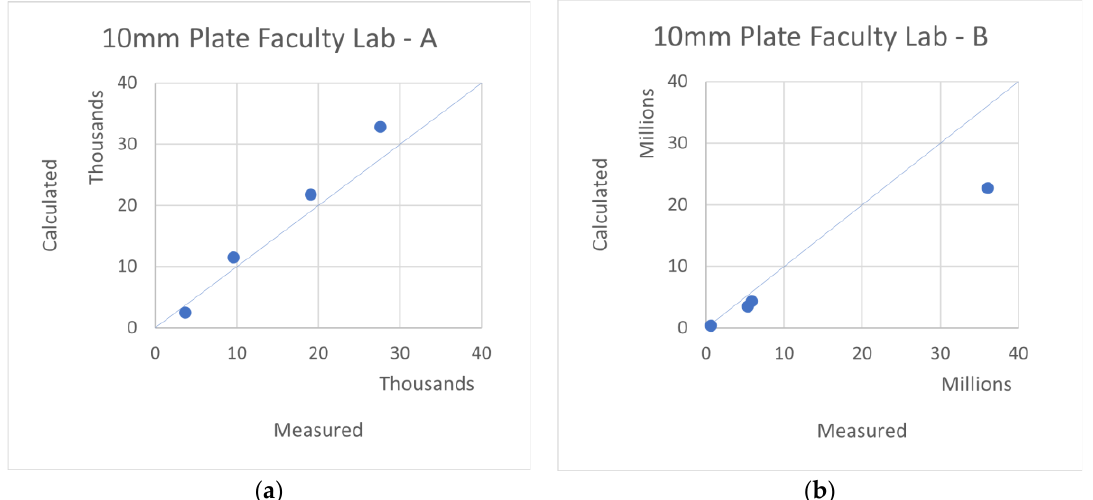
Figure 8. Measured – Calculated A , B — a comparison of various plates performed recently at the Aer- ospace Lab. ( a ) 10 mm A, ( b ) 10 mm B.